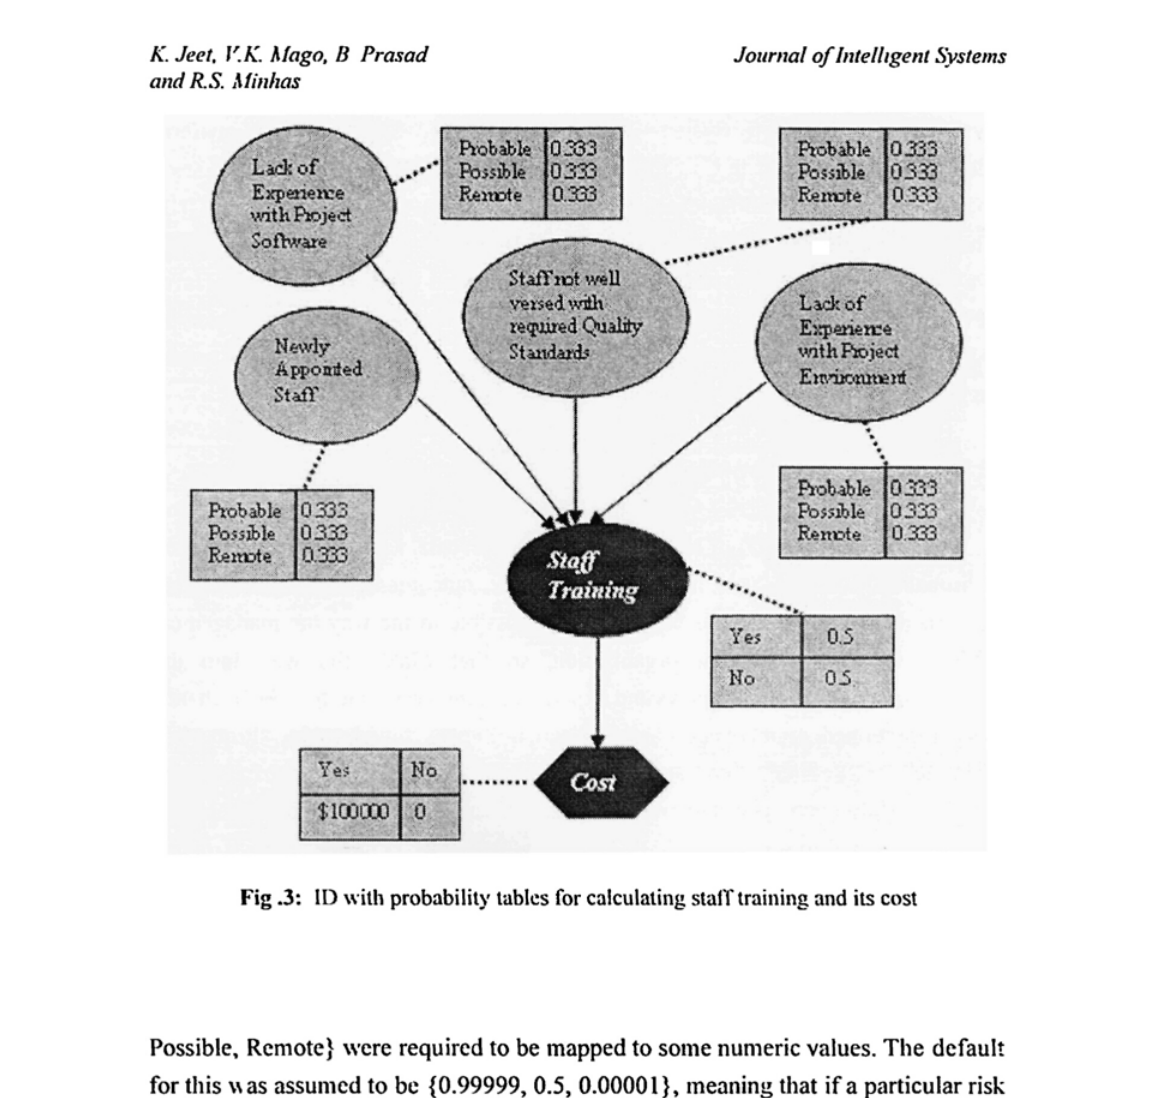
Possible, Remote} were required to be mapped to some numeric values. The default for this was assumed to be {0.99999, 0.5, 0.00001}, meaning that if a particular risk factor's occurrence was highly probable, then its value would be 0.99999 (very high); if moderate, then it would be 0.5 (medium), and if significantly less, then it would be set to 0.00001 (very